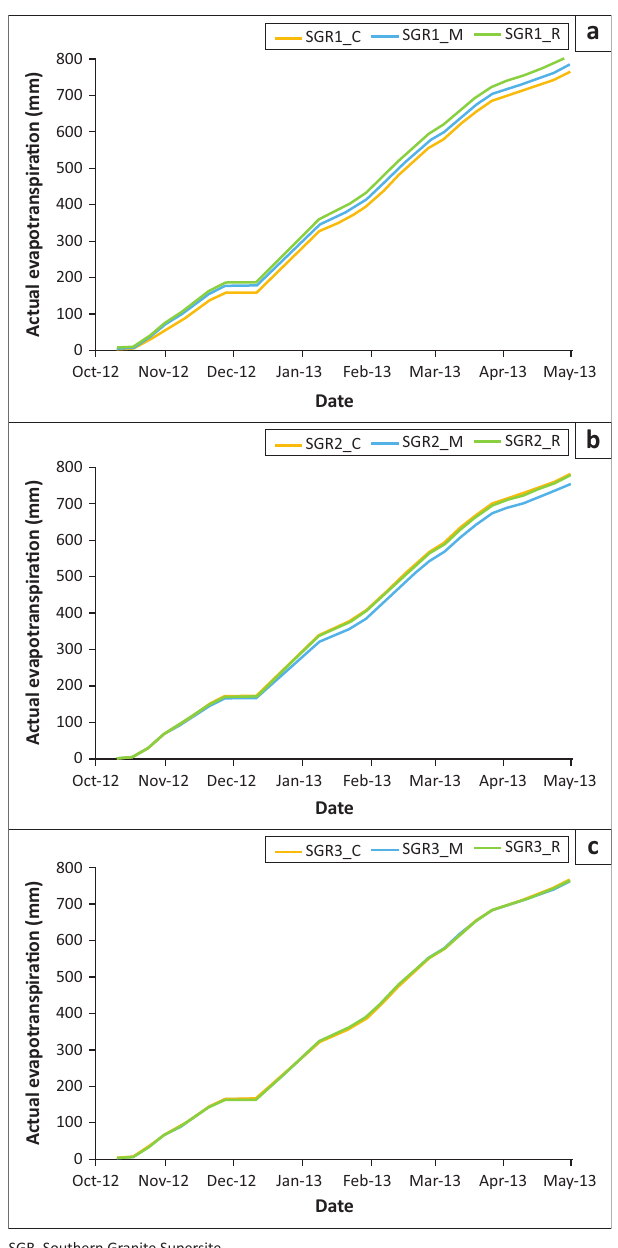
FIGURE 7: Actual cumulative evaporation derived from the Surface Energy Balance Algorithm for Land (SEBAL) model per catena unit (crest, midslope, riparian) in the Southern Granite Supersite streamflows (a) 1, (b) 2, and (c) 3.